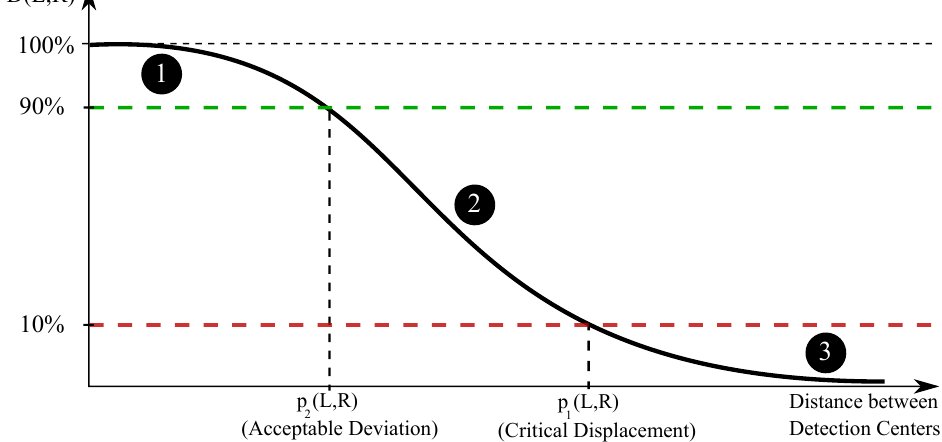
Figure 2. Distance Similarity curve. The argument of this function is the distance between the detection centers. The result for position quality measure is obtained after rescaling the function curve specifically for each comparison. Parameters p 1 and p 2 describe the main thresholds for evaluation of boxes